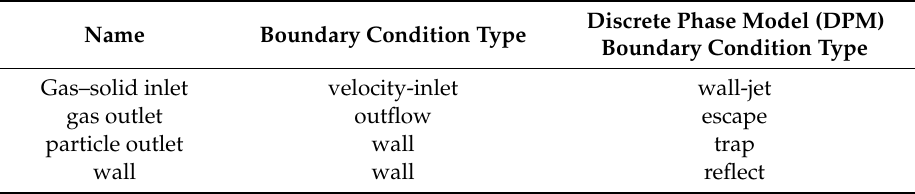
Table 2. The boundary conditions in numeric simulation.